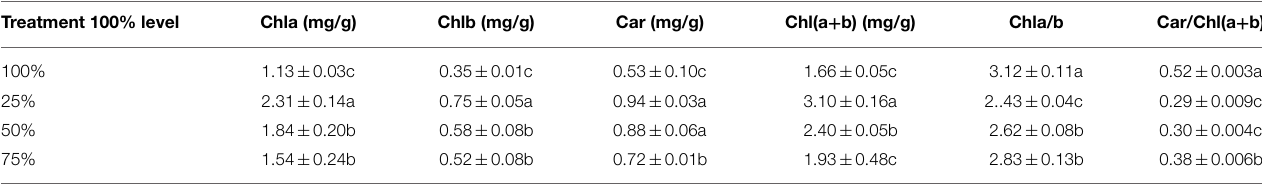
TABLE 2 | Chlorophyll a (Chla), chlorophyll b (Chla), carotenoids (Car), Chl(a + b), chlorophyll a:b ratio (Chla/b) and Car/ Chl(a + b) in C. acuminata leaves in response to different levels of irradiance. Treatment 100% level